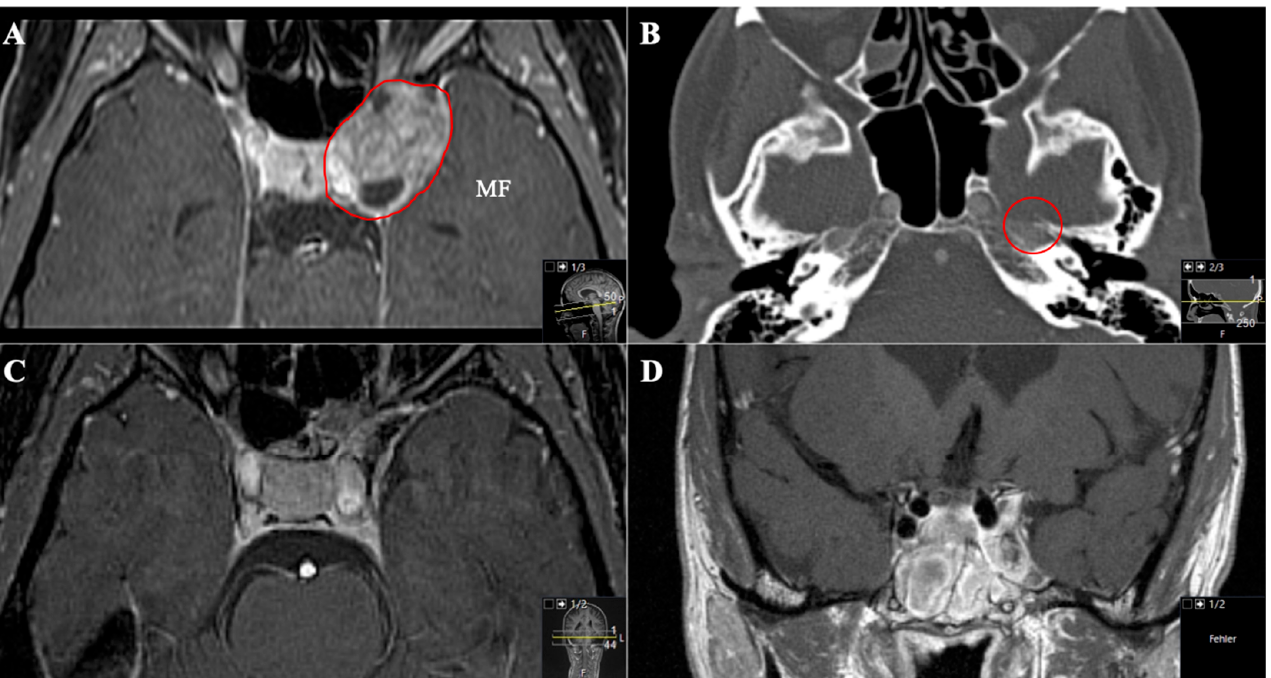
Figure 7 . A 45-year-old female patient presented with left-sided visual impairment and headache. ( A ) Preoperative axial T1-weighted gadolinium-enhanced MRI and ( B ) axial CT, showing an optic-canal-compressing trigeminal schwannoma with a cystic part in Meckel’s cave in the middle fossa (MF, Samii Type A). Note how the foramen rotundum is widened (red circle). ( C ) Postoperative axial and ( D ) coronal MRI control, indicating complete resection via a transnasal endoscopic (transpterygoid) approach using a nasoseptal flap.